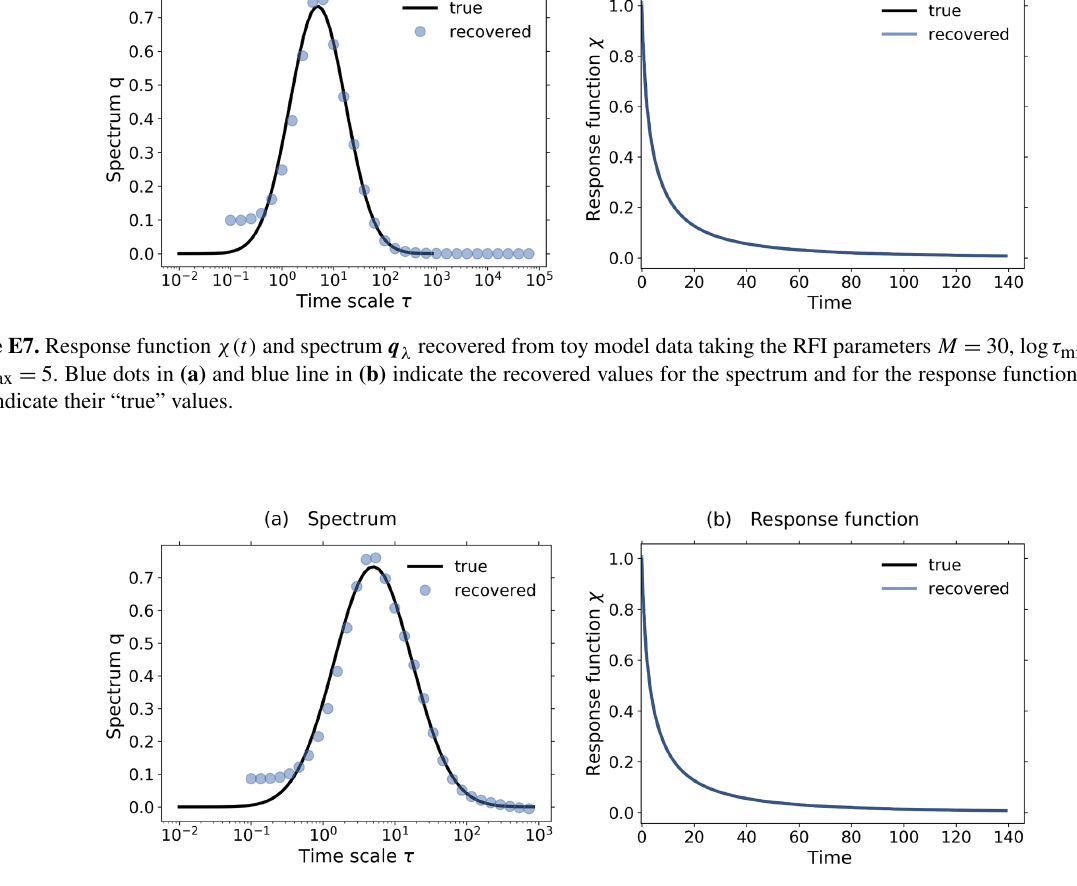
Figure E8. Response function χ(t) and spectrum q λ recovered from toy model data taking the RFI parameters M = 30, log τ min = − 1, and log τ max = 3. Blue dots in (a) and blue line in (b) indicate the recovered values for the spectrum and for the response function, while black lines indicate their “true”